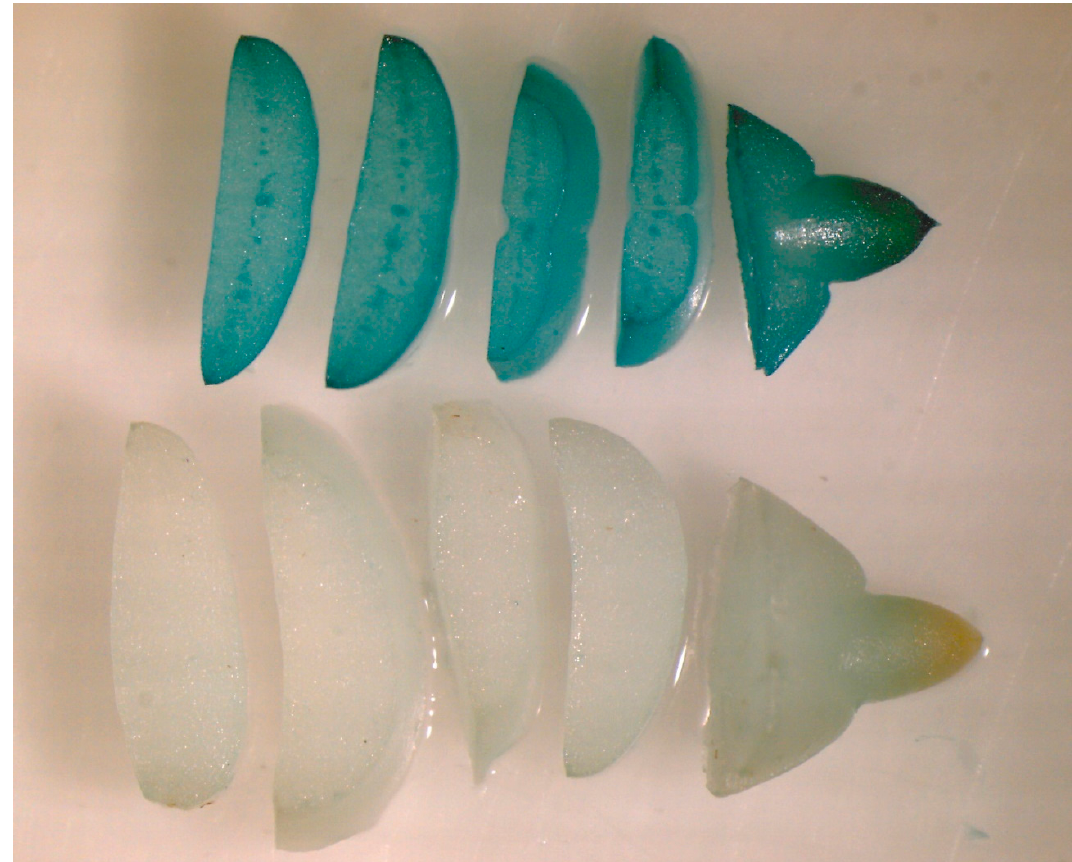
Figure 4. Histochemical GUS assay in pear seeds.